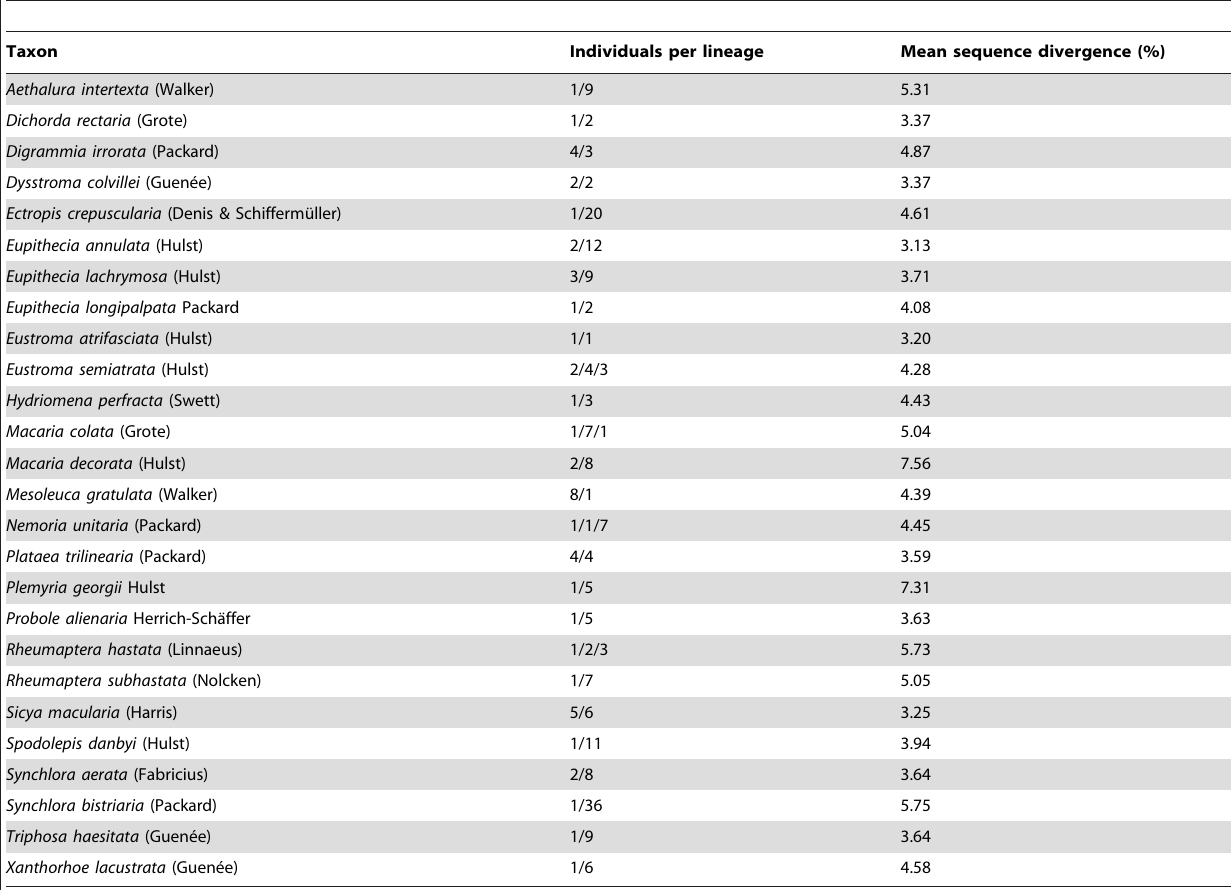
Table 2. Geometrid species with high intraspecific COI